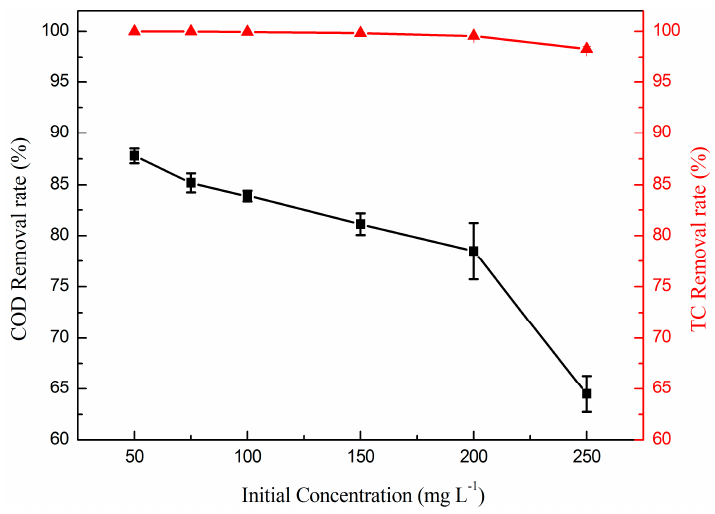
Figure 7. Effect of initial concentration on the removal rate of TC ( ▲ ) and COD ( ■ ). ( RT = 4.4 min, T = 25 °C, and j = 1 mA·cm − 2 ).